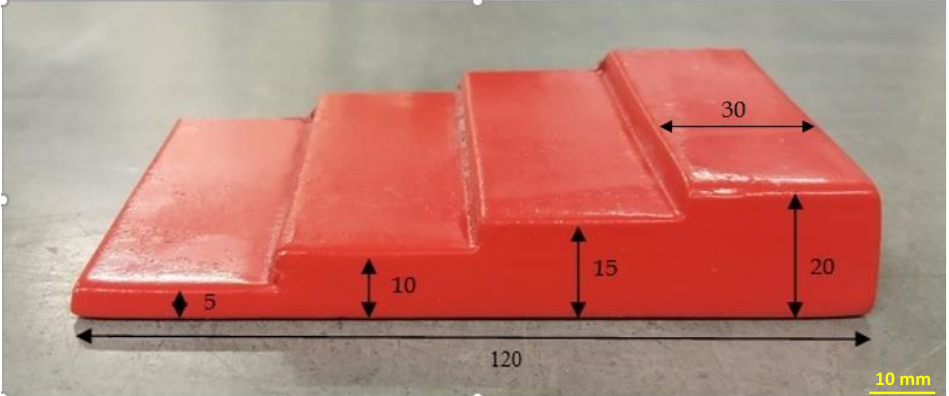
Figure 1. Model for molding foundry molds [27,28].